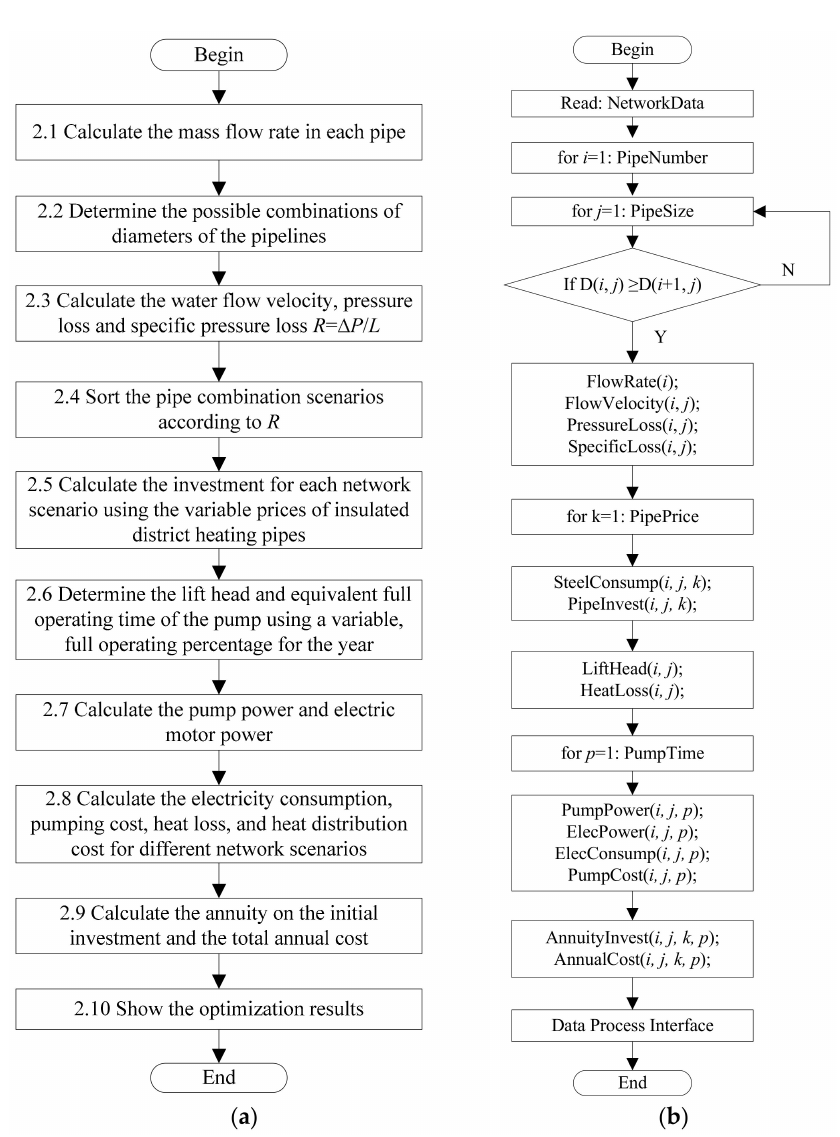
Figure 1. The flowchart of DH network optimization. ( a ) General flowchart; ( b ) Algorithm